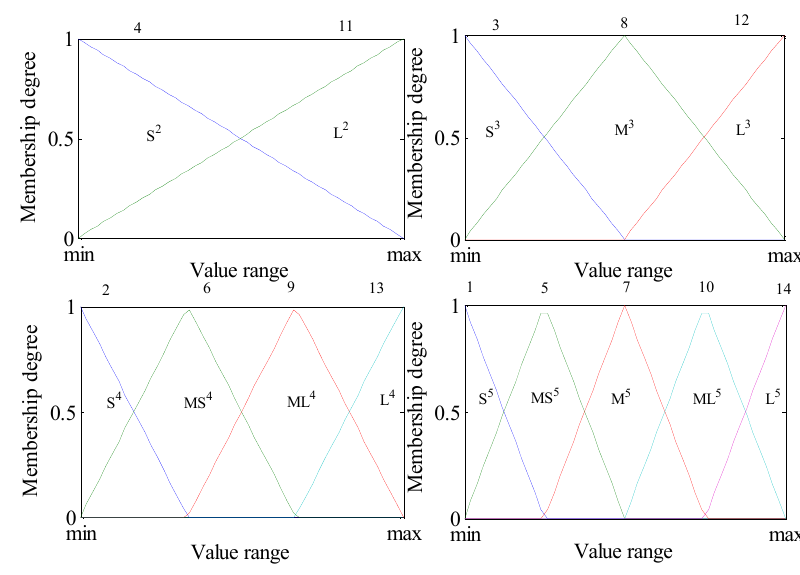
Figure 1. Fuzzy partition of state variables.